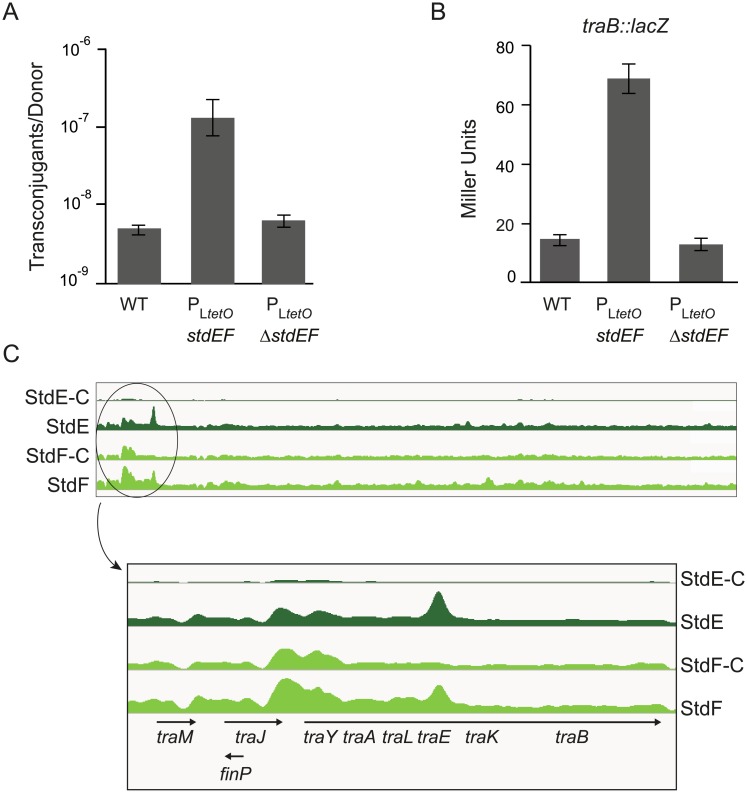
Regulation of conjugal transfer by StdE.A. Conjugal transfer of the virulence plasmid. Donors were the wild type strain, PLtetO-stdEF spvA (SV7554) and PLtetO-ΔstdEF spvA (SV7555). The recipient was trg::mudQ pSLT- (SV4938) in all matings. Values are averages and standard deviations from 3 independent experiments. B. β-galactosidase activity of a traB::lacZ fusion in strains traB::lacZ (SV7551), PLtetO-stdEF traB::lacZ (SV7550), and PLtetO-ΔstdEF traB::lacZ (SV7549). C. ChIP-seq data for the tra operon of the virulence plasmid. In the lower part of the figure, the promoter-proximal tra region is enlarged. StdE-C and StdF-C indicate binding peaks found for the mock IP-sample.